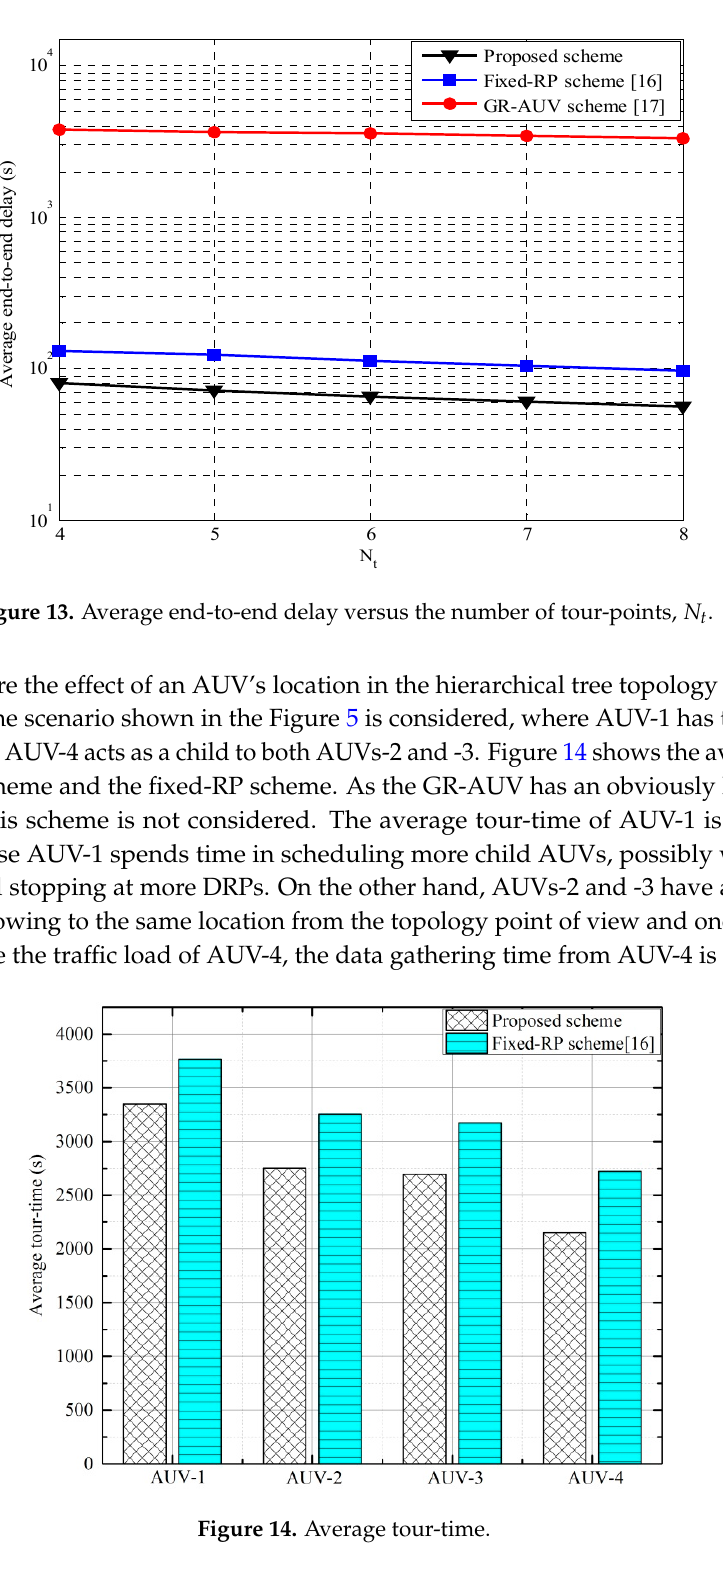
Figure 14. Average tour-time. Figure 14. Average